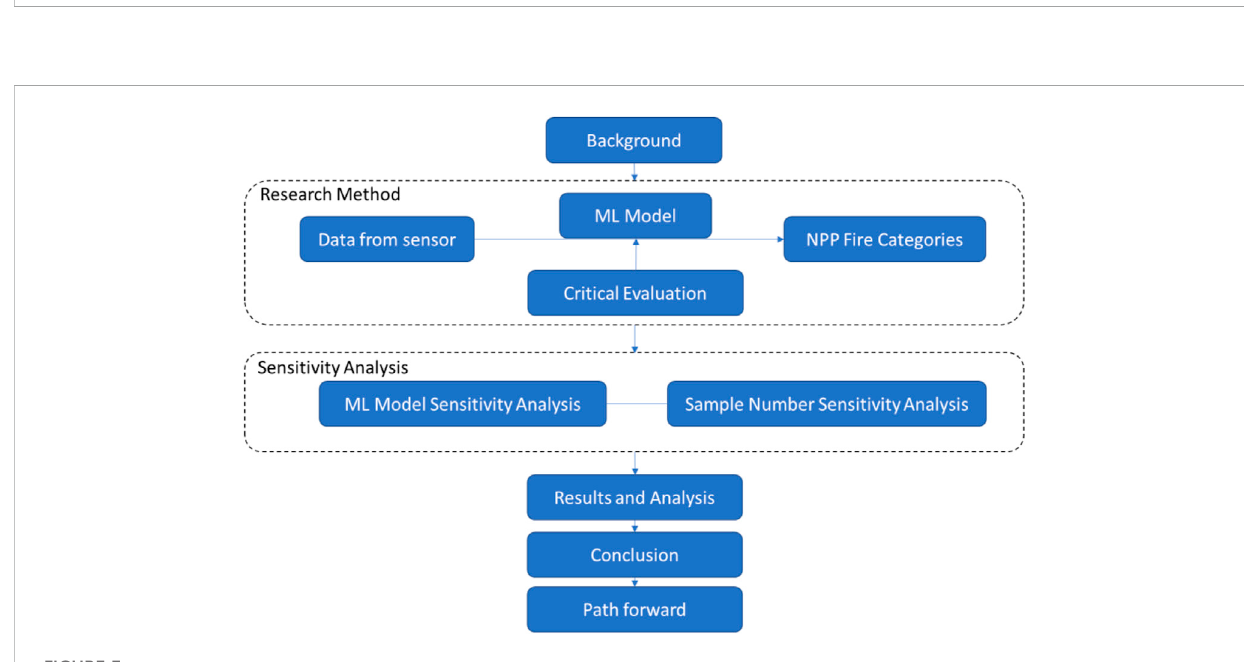
FIGURE 3 Main steps of this